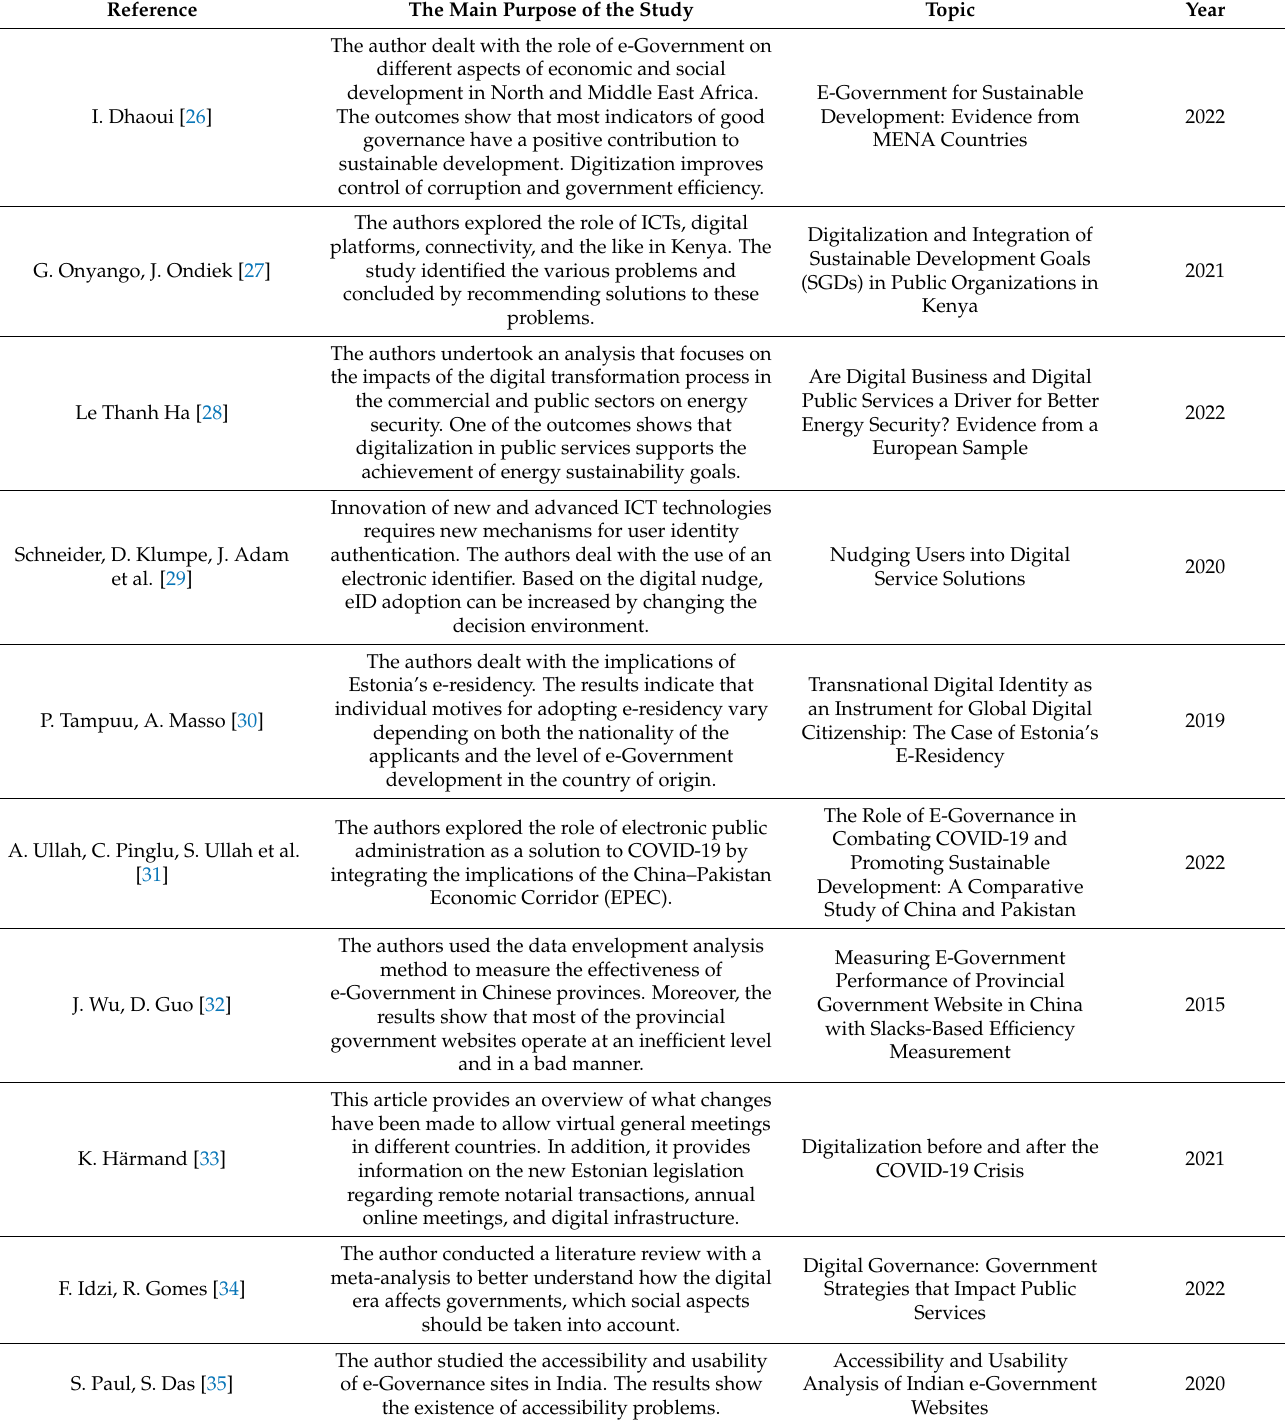
Table 5. Literature review on digitization and